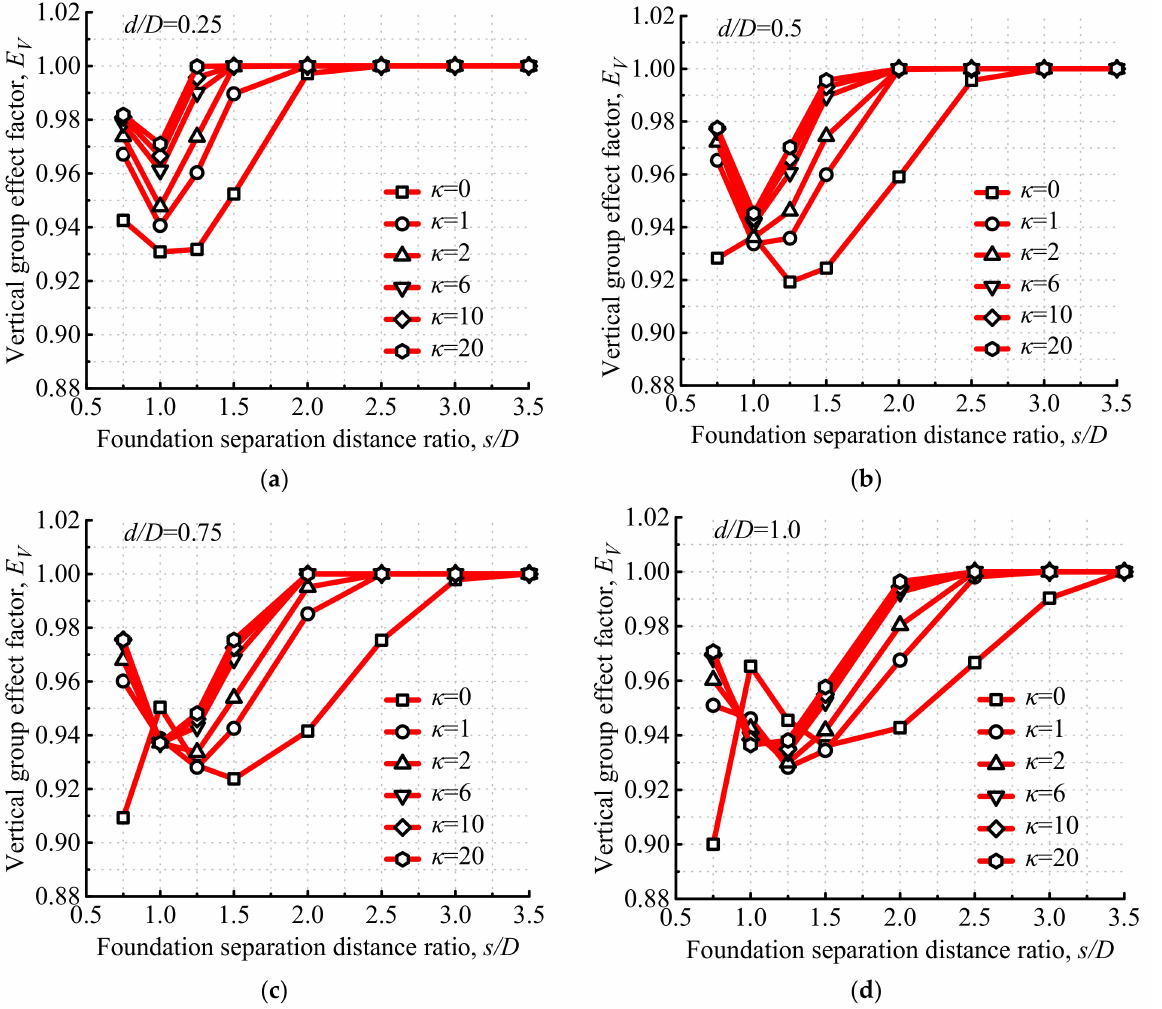
Figure 9. Vertical group effect factors of tetrapod bucket foundations under various κ : ( a ) d/D = 0.25, ( b ) d/D = 0.5, ( c ) d/D = 0.75 and ( d ) d/D =